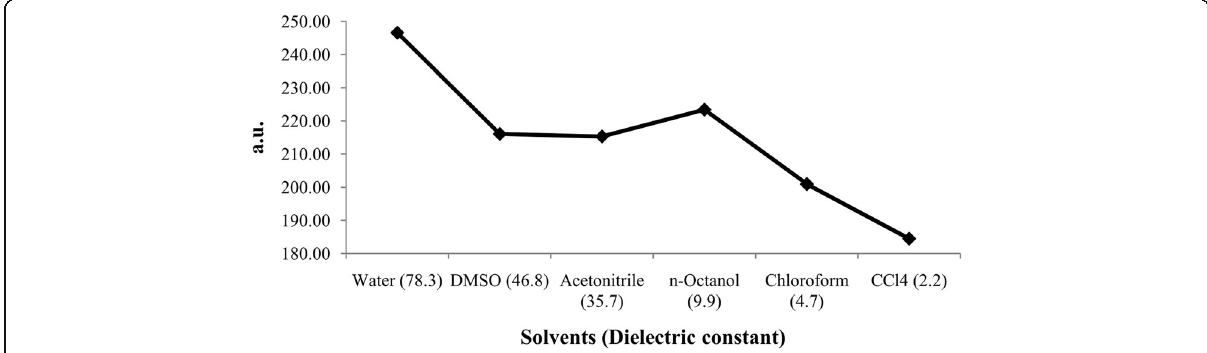
Fig. 10 Effect of solvent polarity on first order hyperpolarizability of betulinic